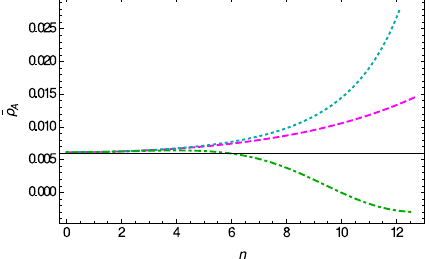
Fig. 27 Variation of the energy density of the three-form field ¯ ρ A as a function of the radial coordinate η for three-form field Bose–Einstein condensatestarsinthepresenceofaHiggs-typepotentialfor ¯ a = 0 . 001, and three different values of the constant ¯ b : ¯ b = 0 (dashed curve), ¯ b = − 0 . 1 (dotted curve), and ¯ b = 0 . 6 (dot-dashed curve), respectively